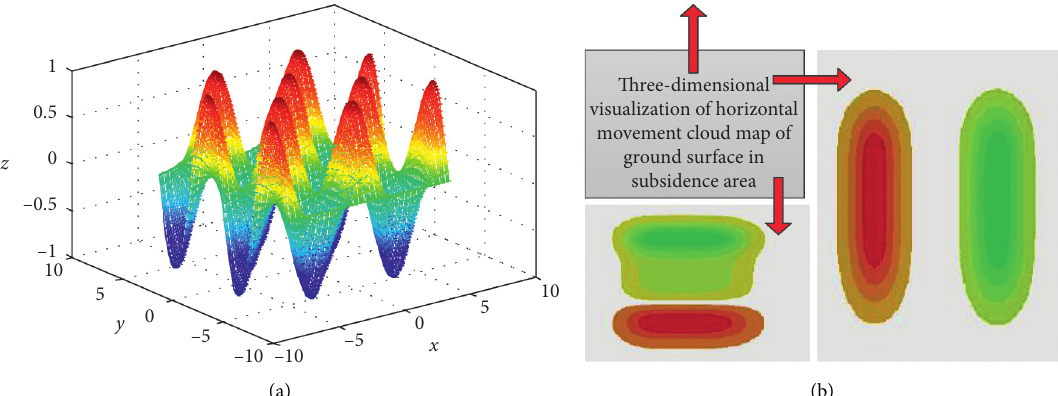
Figure 14: Three-dimensional visualization of horizontal movement cloud map of ground surface in subsidence area. (a) Global map of surface deformation. (b) Horizontal and vertical details.